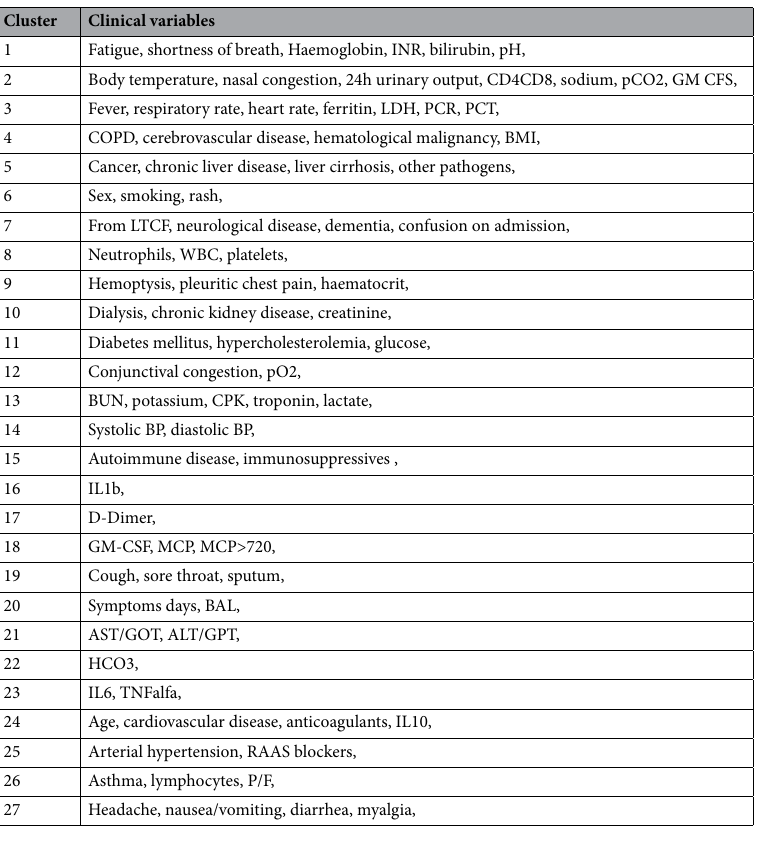
Table 7. Clustering of clinical